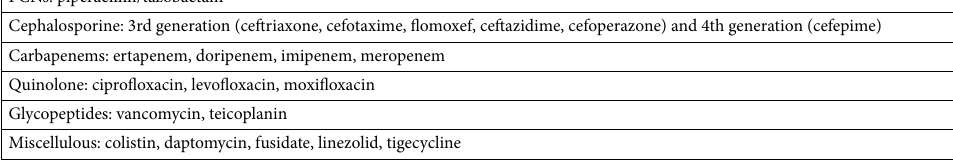
Table 1. The list of restrictive